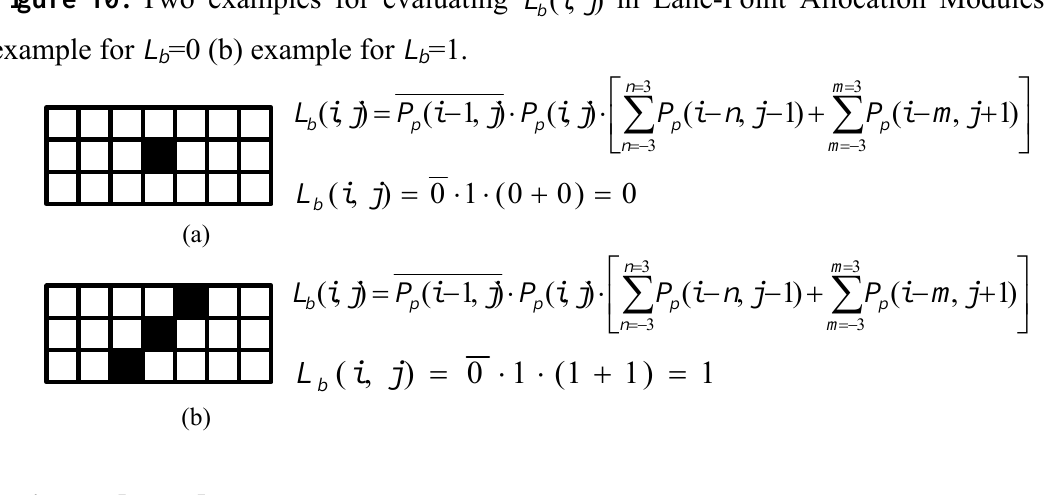
Figure 10. Two examples for evaluating ),( jiL example for L =0 (b) example for L b